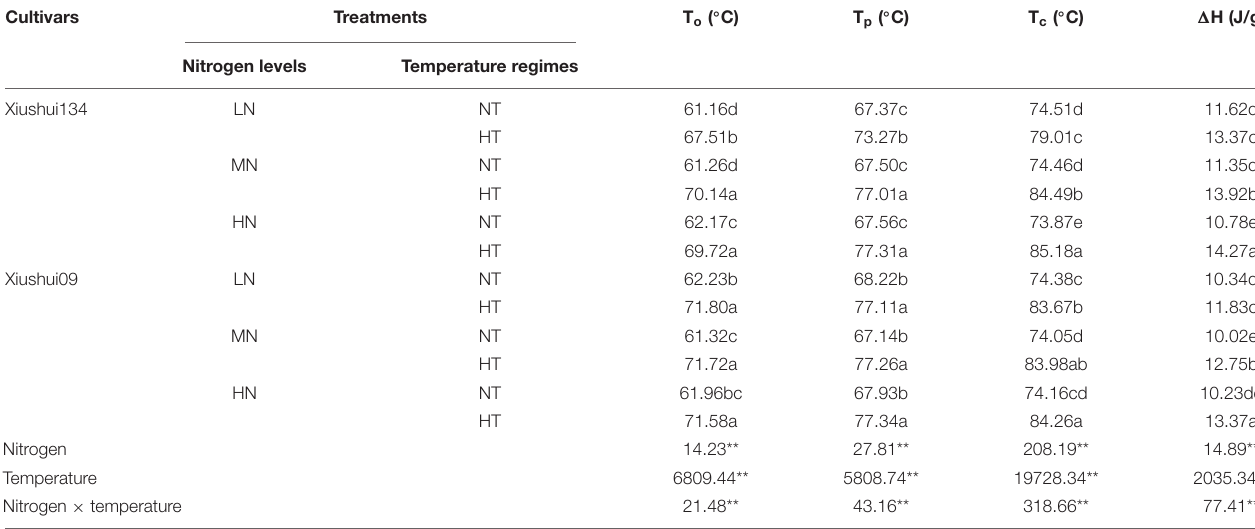
TABLE 4 | Difference in DSC parameters among different treatments. Cultivars Treatments